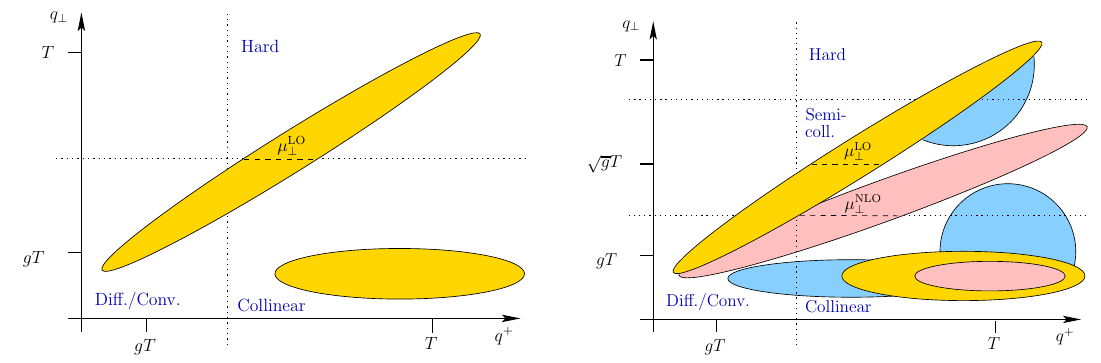
Figure 4 . Left: kinematic regions, in terms of exchanged transverse momentum and exchanged light-cone momentum q + , which are relevant at leading order. Right: the same regions (yellow) plus regions which are relevant at next-to-leading order (pink) and where subtractions of leading-order e(cid:11)ects are needed